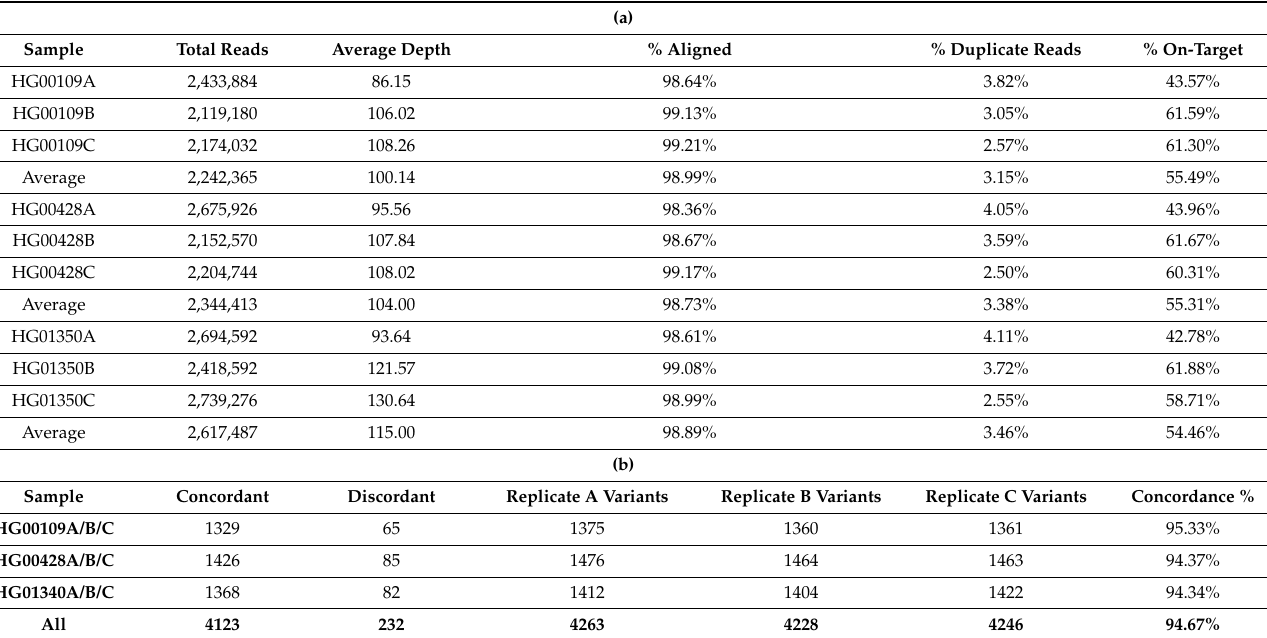
Table 3. ( a ) Intra-precision study results; ( b ) Intra-precision variant